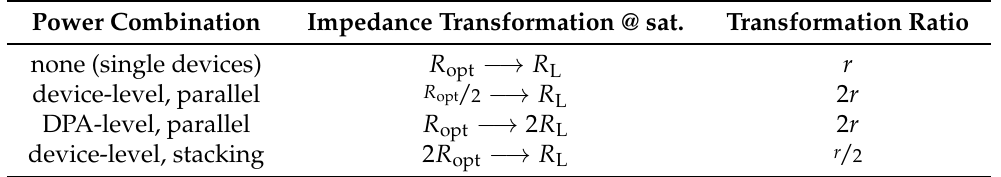
Table 2. Impedance transformation of various power combination